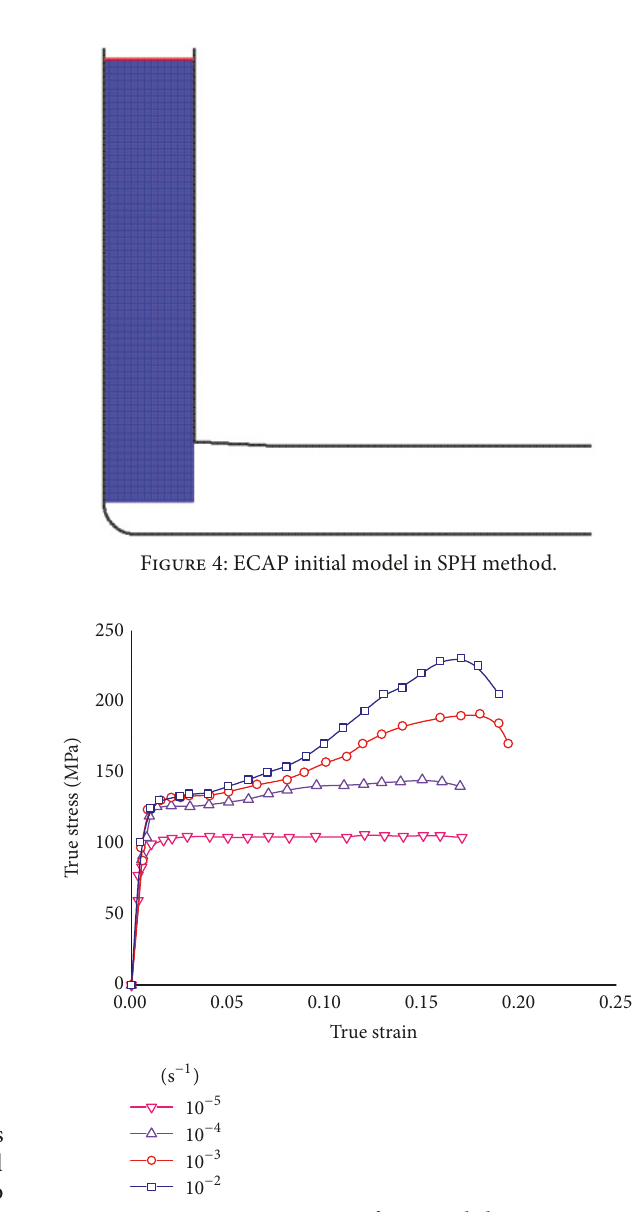
Figure 5: True stress-strain curve of as-extruded pure magnesium compression at room